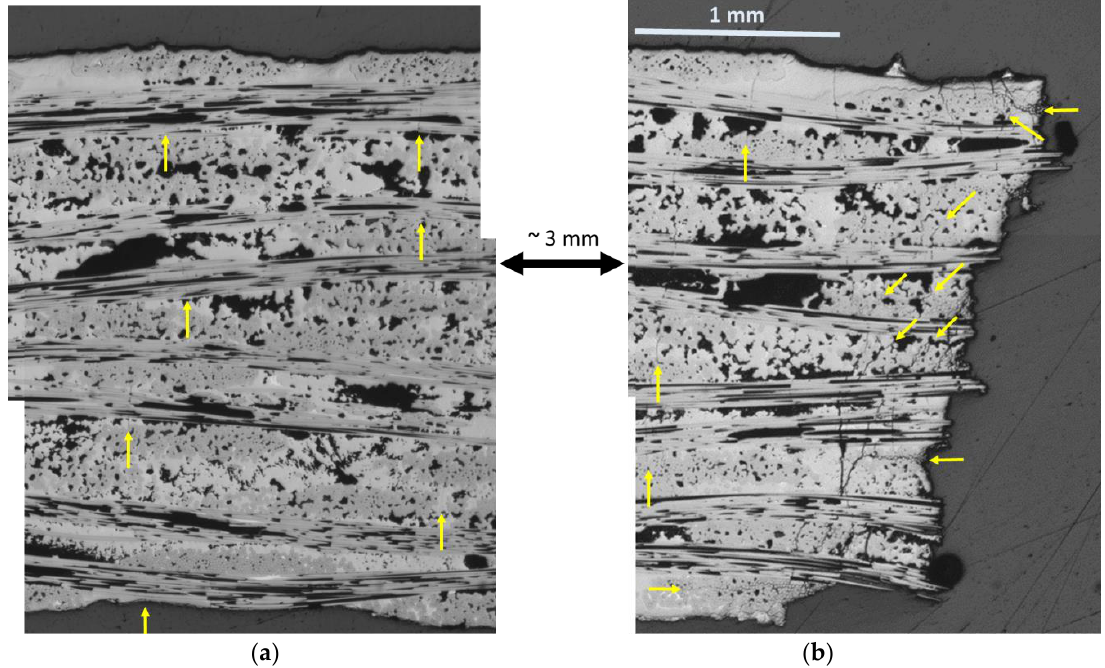
Figure 10. Polished longitudinal sections of 113-3 CMC specimen ( a ) far from fracture surface and ( b ) near fracture surface showing increased damage regions near fracture surface.